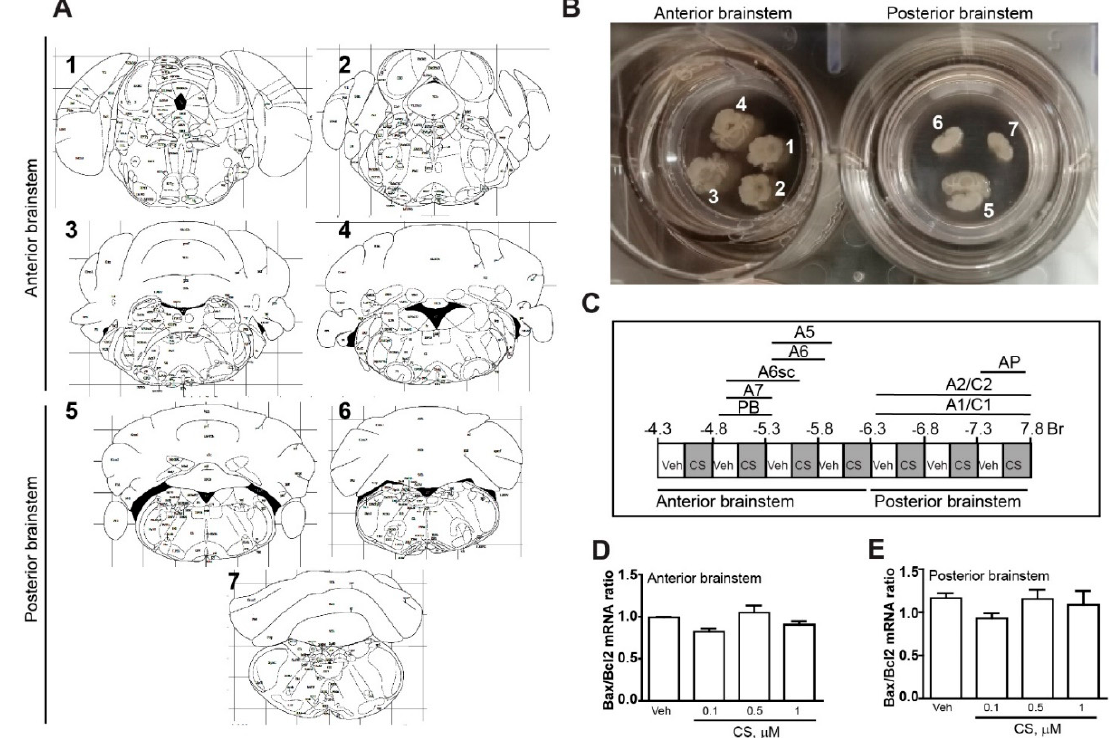
Figure 1. Organotypic cultures of the mouse brainstem. ( A ) Plates of brain atlas corresponding to the level chosen for rostral (1–4) and caudal (5–7) slices to set up organotypic cultures. ( B ) Authentic organotypic slices cultured from mouse brainstem. ( C ) Map of catecholamine nuclei of the mouse brainstem from pons to medulla oblongata from Bregma = − 4.3 to Bregma = − 7.8. The diagram shows the anatomical localization of each brainstem catecholamine nuclei. From each brainstem, 16 coronal sections (250 µ m thickness) were sampled with a 250 µ m interval. Eight sections were treated with vehicle (Veh), while 8 were administered various corticosterone (CS) doses. The diagram shows the rostro-caudal extension of the rostral (from Bregma = − 4.3 to Bregma = − 6.3) and the caudal part (from Bregma = − 6.3 to Bregma = − 7.8) of the mouse brainstem. ( D , E ) Real time PCR analysis of the Bax / Bcl2 mRNA ratio in organotypic cultures of the rostral or caudal part of the mouse brainstem at 24 h vehicle (Veh, ethanol 0.01%) or CS (0.1, 0.5 or 1 µ M in ethanol 0.01%) incubation. The value reported for the vehicle in Figure 1D was standardized based on vehicle of Figure 1C. This means that in baseline conditions, the BAX/Bcl2 ratio is higher in the caudal compared with rostral brainstem.